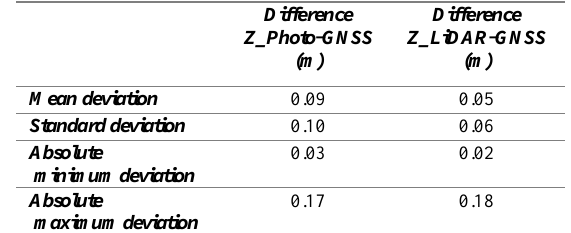
Table 3 . Altimetric